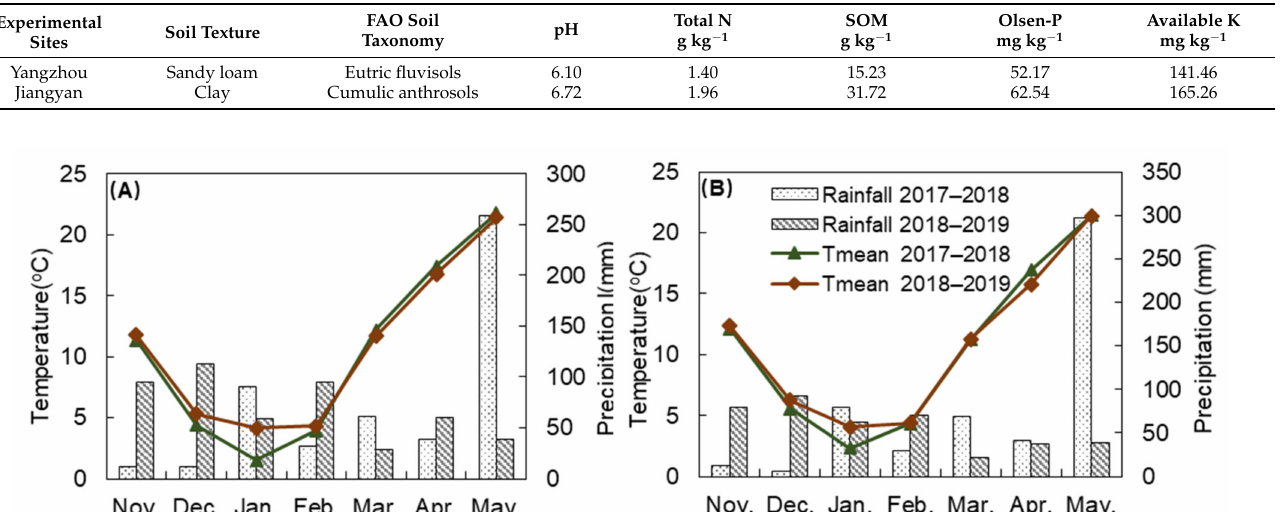
Table 1. Soil properties at different experiment sites.